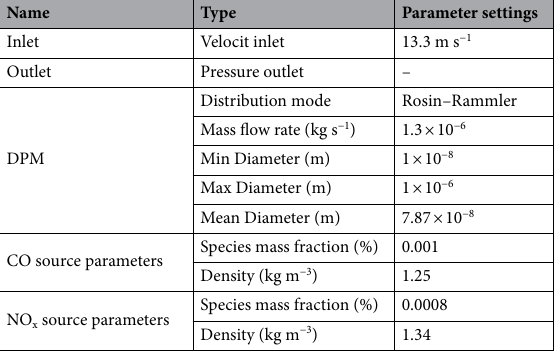
Table 1. Parameter setting.